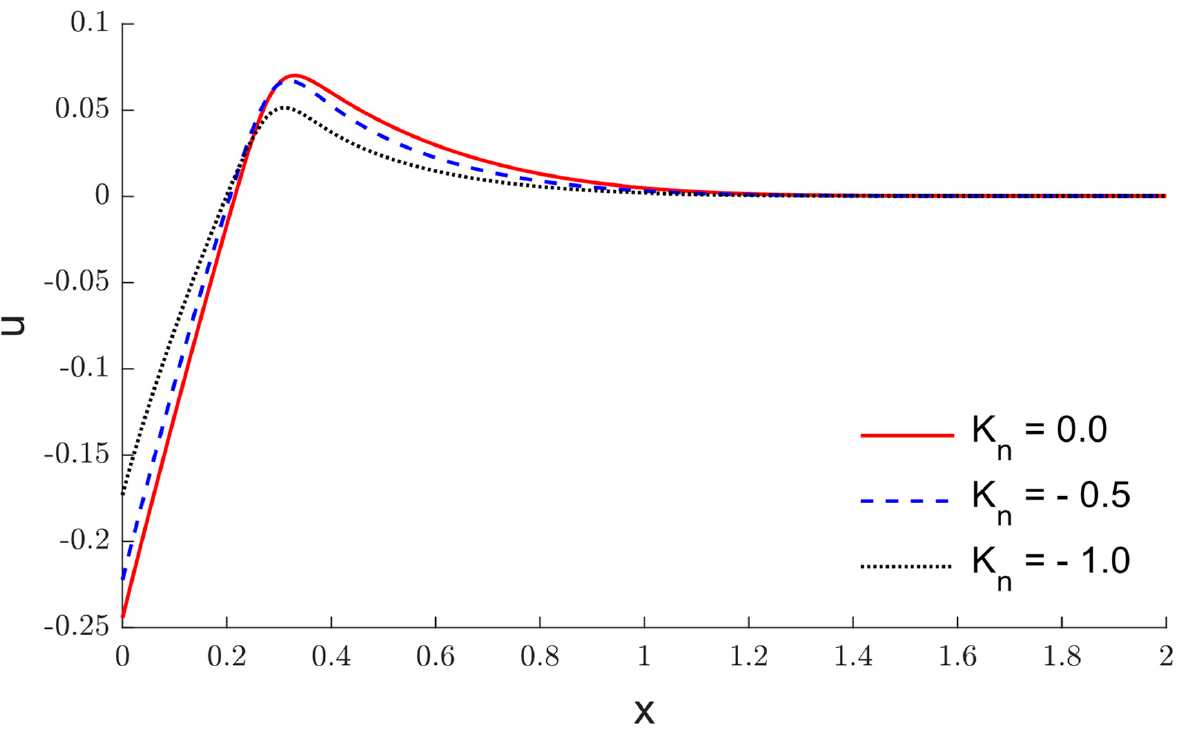
Figure 2. The impact of variable thermal conductivity and diffusivity in the displacement variation u via the distance x when τ o = τ 1 = 0.05.